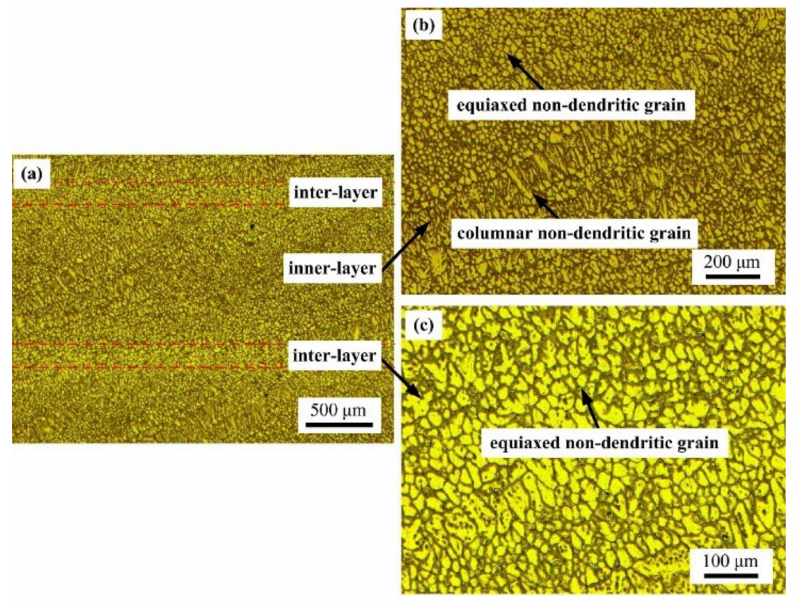
Figure 14. Optical microscopic images of WAAM Al-Cu-Mg alloy: ( a ) Al-3.6Cu-2.2Mg, ( b ) inner-layer of Al-3.6Cu-2.2Mg, ( c ) inter-layer of Al-3.6Cu-2.2Mg. Reprinted from Ref.